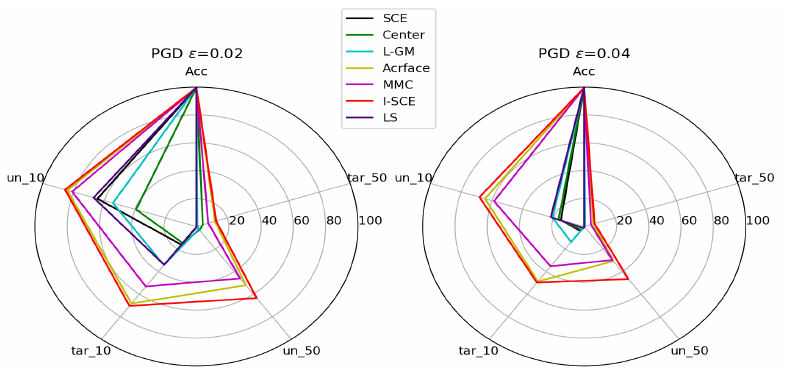
Figure 5. Classification accuracy (%) under PGD attack on MNIST.